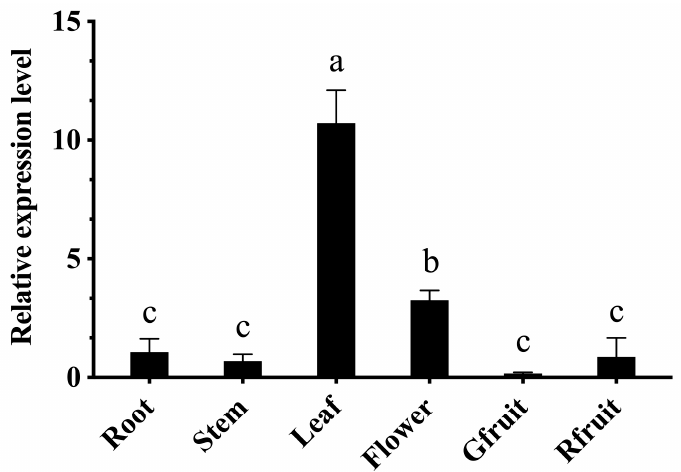
Figure 3. Tissue-specific expression of CaBPM4 in different organs of pepper plants. The samples of root, stem and leaf are collected from A3 pepper plants at the six true-leaf stage, while the samples of flower, Gfruit (green fruit) and Rfruit (red fruit) are collected from mature plants. Relative expression levels of the CaBPM4 in different tissues were determined in comparison with that in roots. Results are presented as the means ± SD of three independent biological replicates. Small letters (a–c) represent significant differences ( p < 0.05).